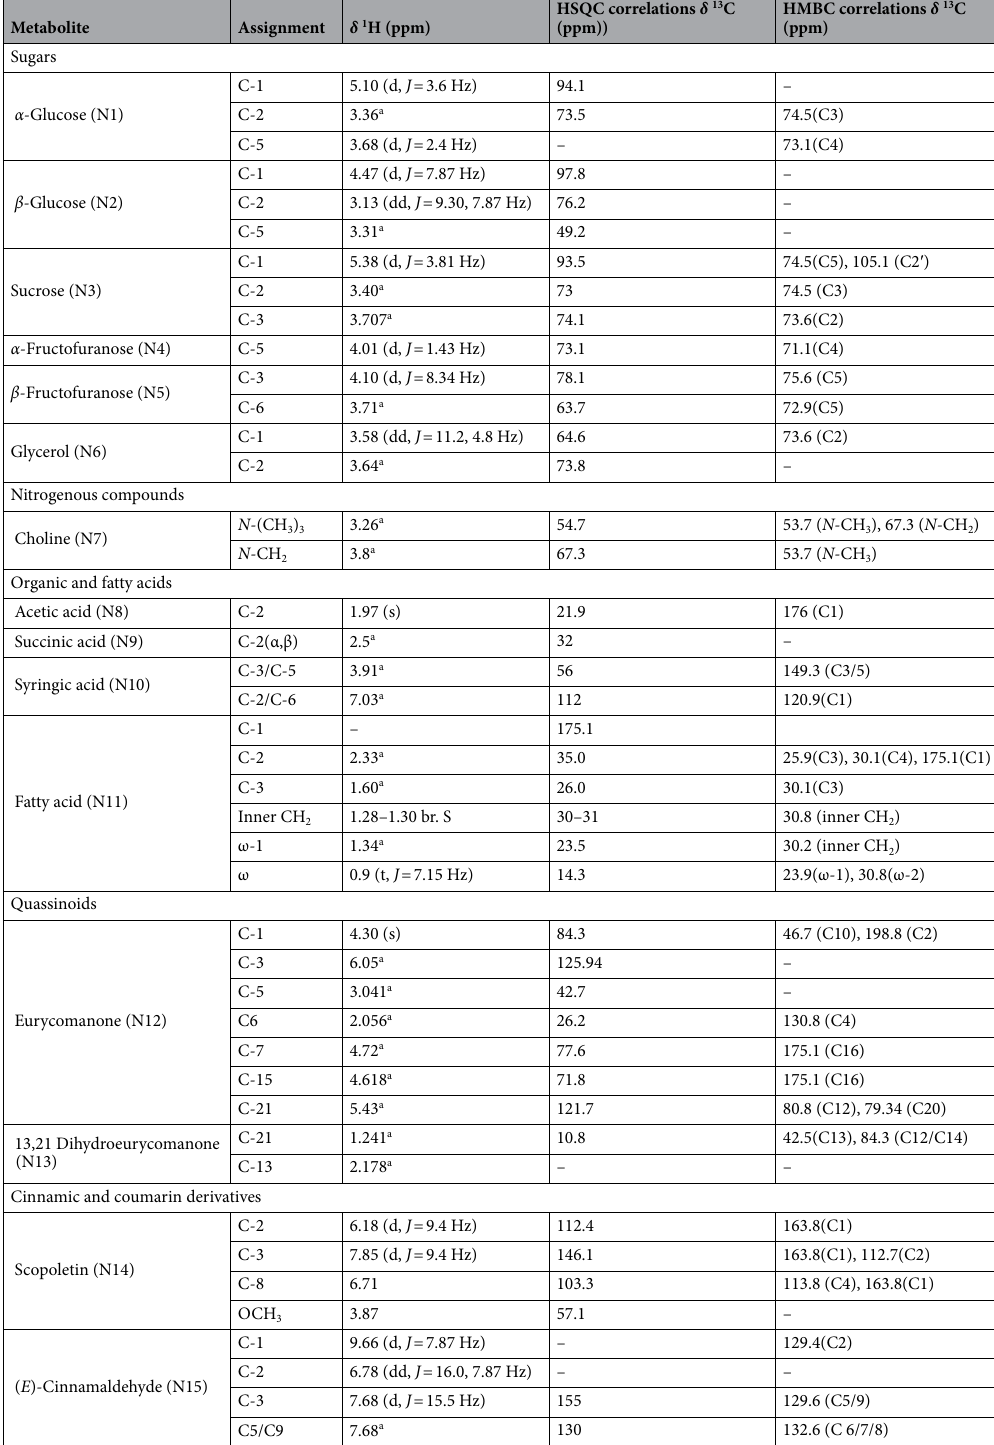
Table 1. Resonance assignments with chemical shifts of constituents identified in 600 MHz 1 H-NMR, HSQC and HMBC spectra of Tongkat Ali ( E. longifolia ) methanol extract. 1 H-NMR quantification of most primary and secondary metabolites are expressed as μg/mg dry powder ± S.D (n = 3), see experimental section. a Overlapped